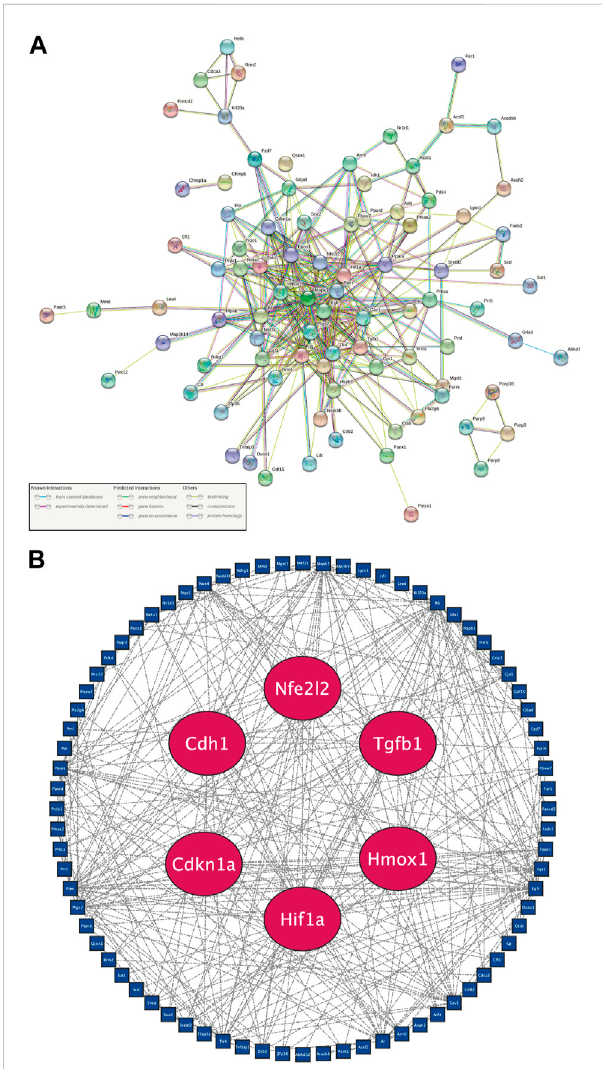
FIGURE 4 Recognition of six hub genes from 108 candidate DE-FRGs. (A) PPI network plotdownloadedfrom theSTRING database. Geneswere represented as nodes, and relationships between them by edges. A node ’ s relationships with other genes are more extensive the more edges it is related to. (B) PPI network plot of candidate DE-FRGs after deleting unconnected nodes. Hub genes are shown by red nodes, and other genes are shown by blue nodes.